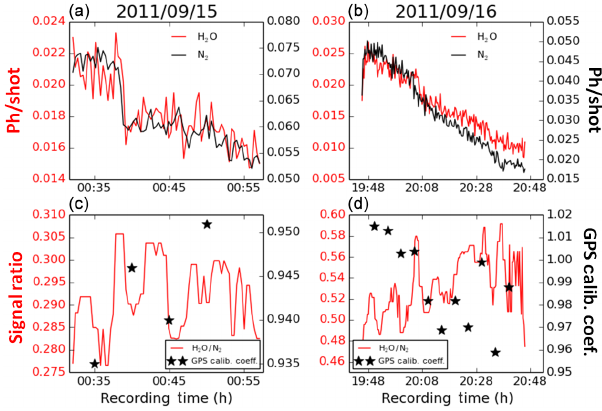
Figure 2. Examples of signal break (a) and signal fading (b) ob- served in the Rameau lidar measurements during the DEMEVAP campaign in 2011. The top panels show H 2 O (red, left-hand axis) and N 2 (black, right-hand axis) signals (photons per laser shot, ph/shot) averaged over the distance range 317–1317 m. The bot- tom panels show the ratio of the two Raman signals (red curve, smoothed with a five-point median filter) and the coincident relative calibration coefficients (black stars) computed from 5min average lidar and ZWD GPS